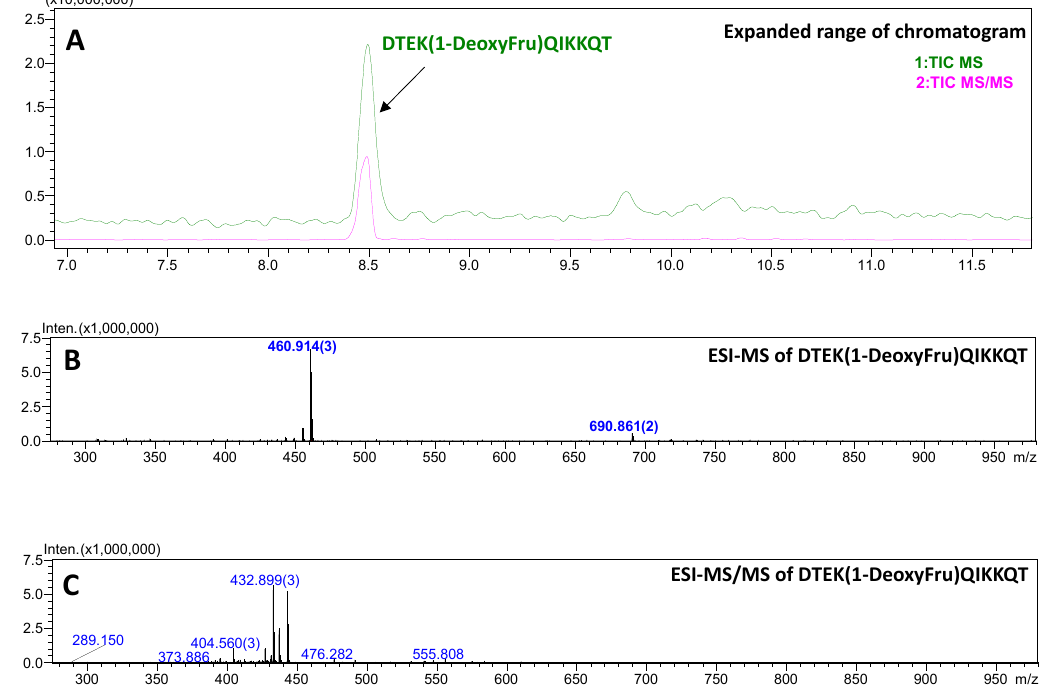
Figure 3 . Analytical characterisation after performing the capturing procedure of the hydrolysate of Bovine Serum Albumin (500 pmol, BSA, BioLabs) with the deoxyfructosylated peptide DTEK(1-DeoxyFru)QIKKQT ( 18 ) (300 pmol). Panel ( A ): Total Ion Chromatogram, expanded range. Panel ( B ): ESI-MS. Panel ( C ): ESI-MS/MS.